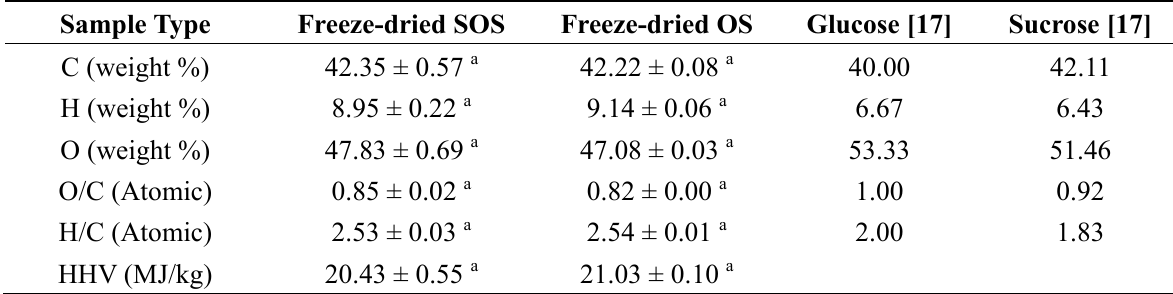
Table 2. Elemental analysis and higher heating values (HHV) of freeze-dried SOS, OS, glucose, and sucrose